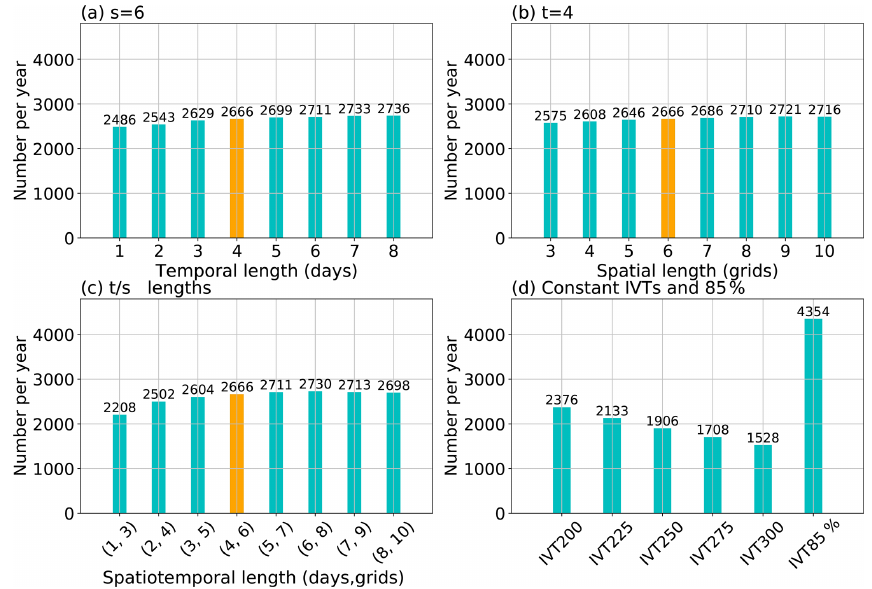
Figure 4. Average annual number of AR occurrences over the North Pacific during 2004–2010. (a) AR occurrence numbers by the THR method with various time ( t ) parameters and a fixed space parameter ( s = 6). (b) Similar to panel (a) but for fixed time ( t = 4) and varying space ( s ) parameters. (c) Results from the THR method with time ( t ) and space ( s ) varying simultaneously from the lower bound of t = 1d, s = 3 grids to the upper bound of t = 8d, s = 10 grids. (d) AR occurrences from the constant IVT thresholding method with the threshold value ranging from 200 to 300kgm − 1 s − 1 and the result from the IVT85% method as in the last